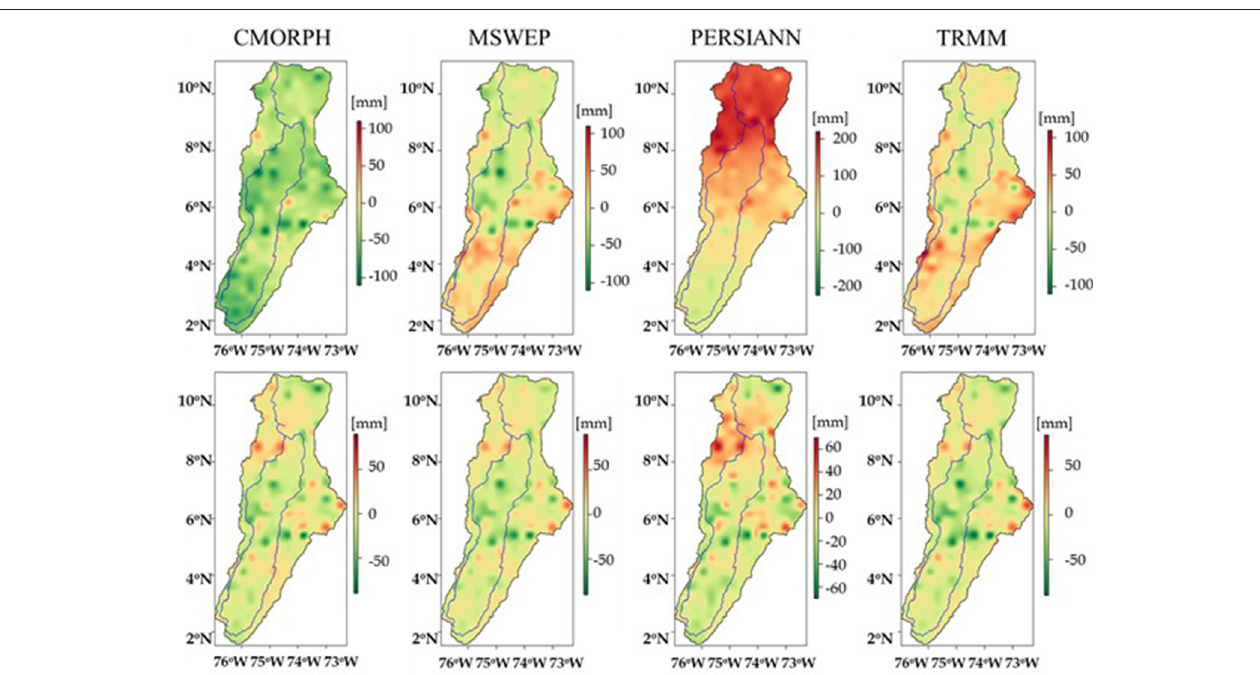
FIGURE 6 | Interpolated difference between CMORPH, MSWEP, PERSIANN, and TRMM precipitation datasets at 25km ( P , first row) and 1km ( PDI , second row) and in situ observations for the 2000–2012 period.